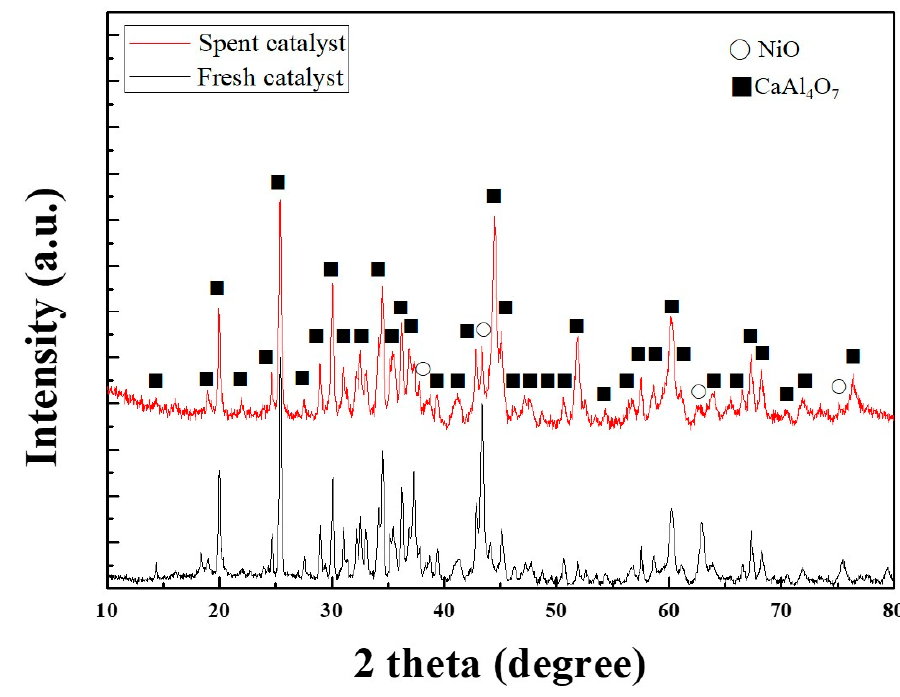
Figure 5. XRD patterns of the fresh and spent catalysts.